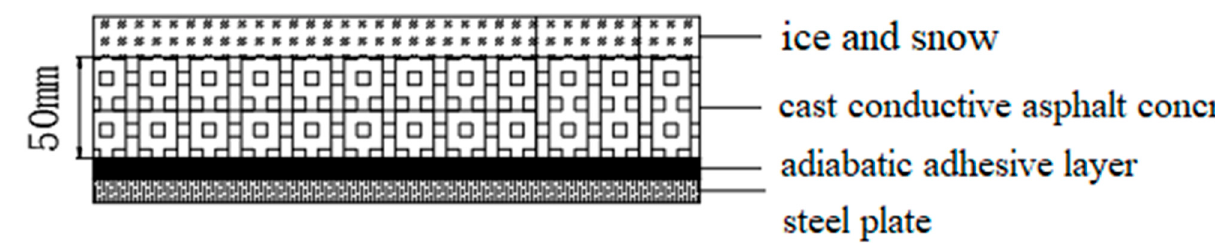
Figure 11. Casting conductive asphalt concrete ice melting model.